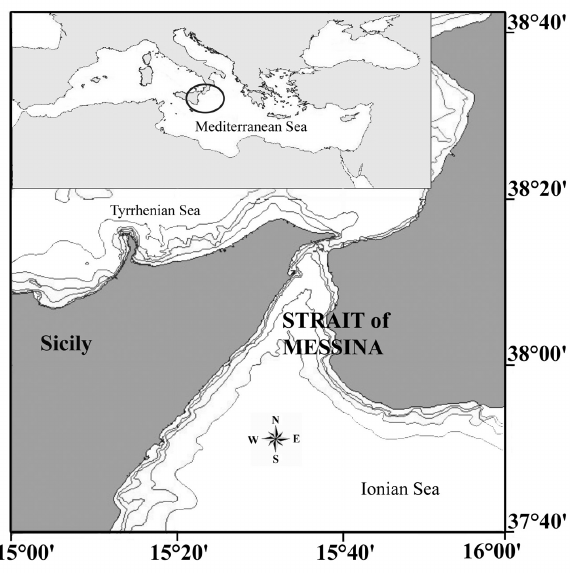
Fig . 1. – Map of the Mediterranean Sea showing the location of the study area in the Strait of